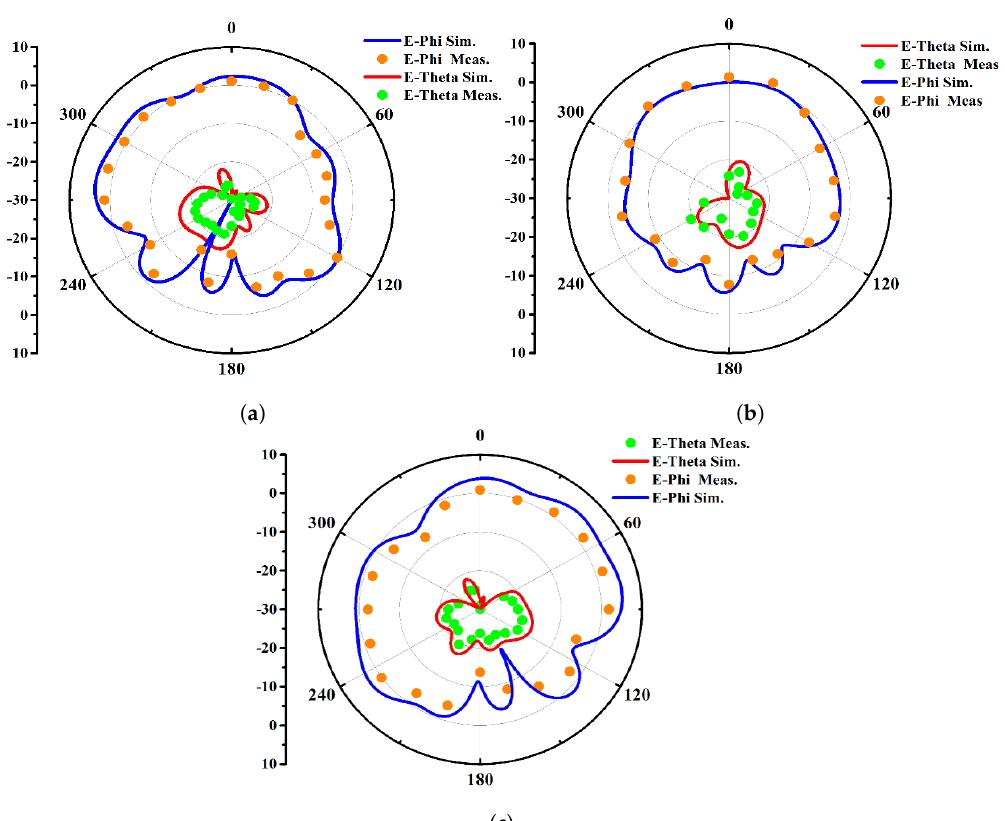
Figure 7. Measured and simulated radiation pattern x-y plane for ( a ) Ant1, ( b ) Ant3, and ( c ) Ant5.